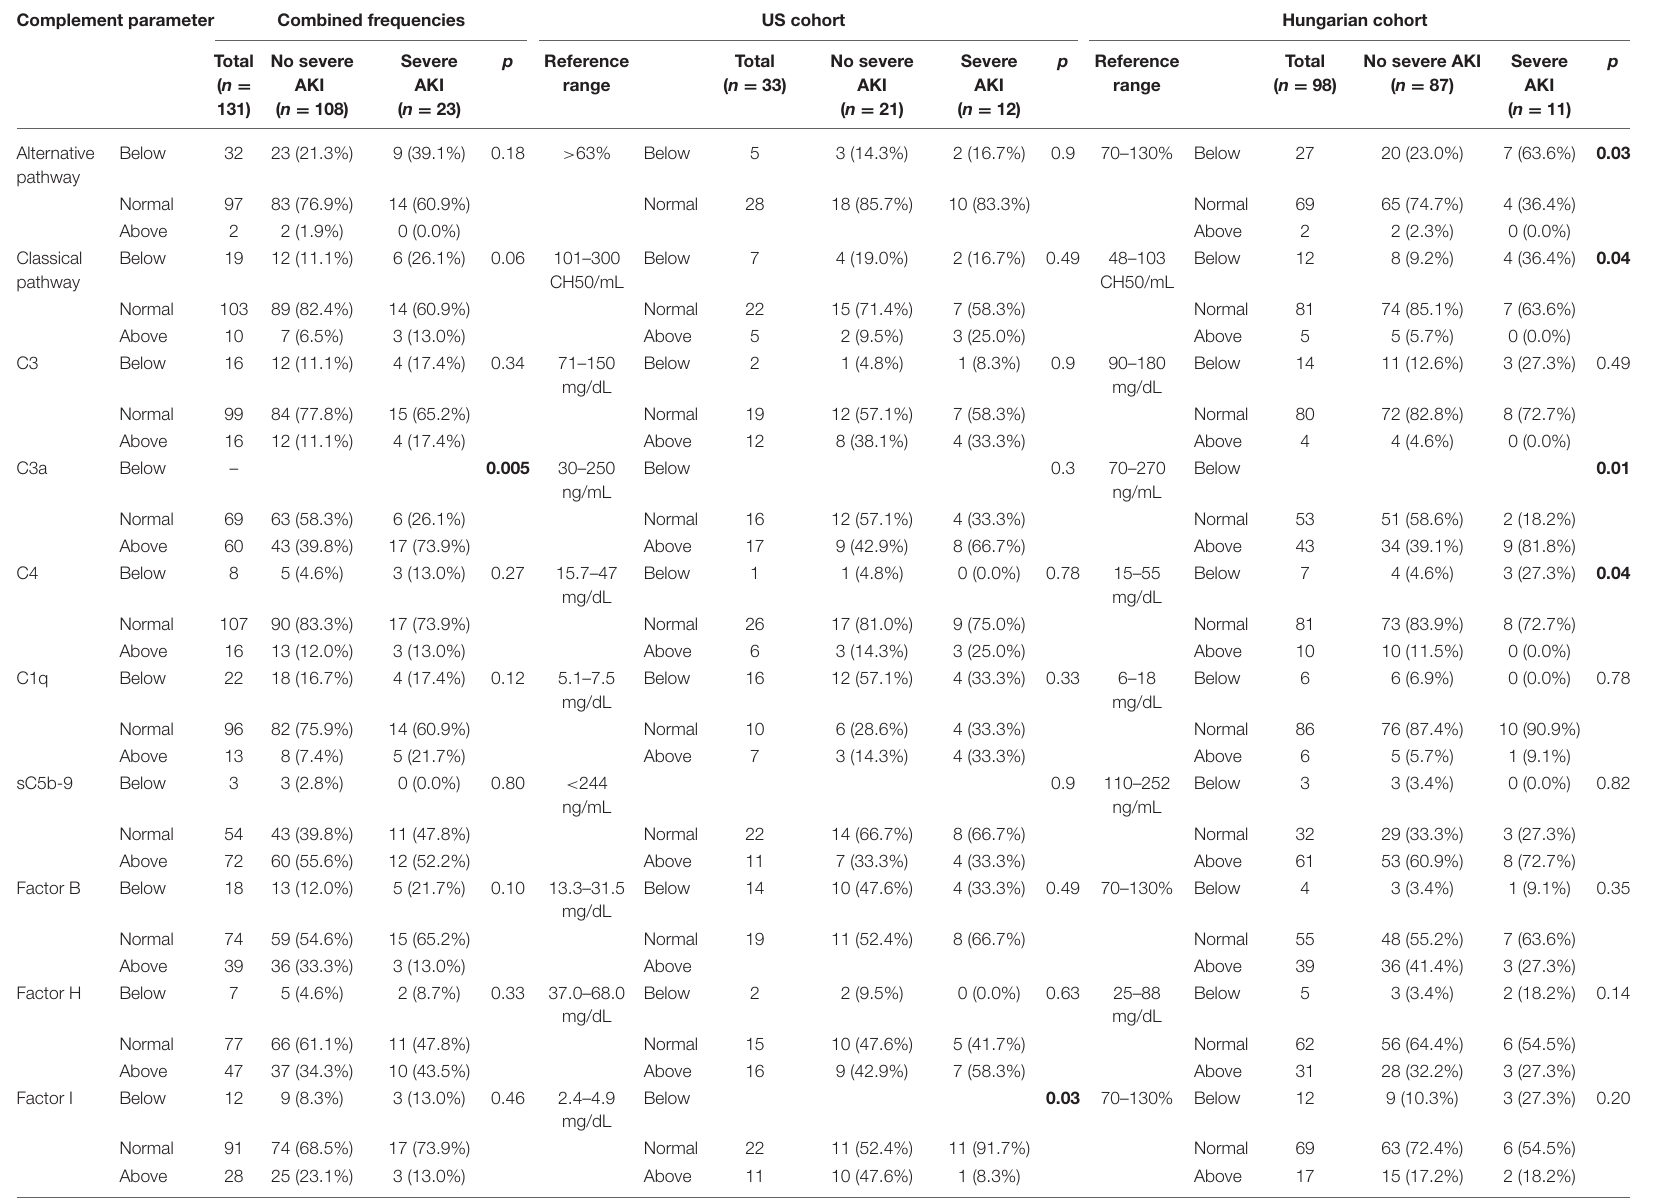
TABLE 2 | Frequency of COVID-19 patients with levels of complement parameters below, within, or above their respective reference range, in total and stratified according to cohort and AKI